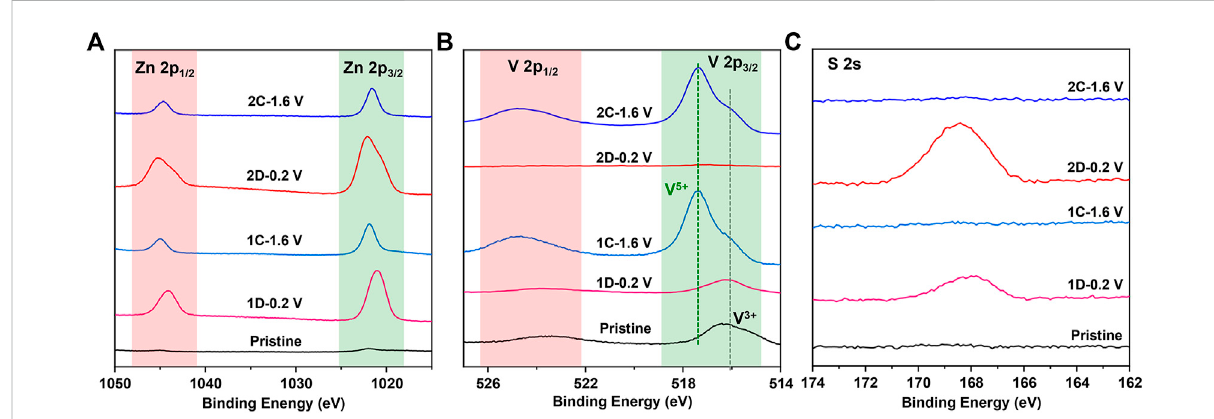
FIGURE 5 XPSspectraof (A) Zn2p, (B) V2p,and (C) S2sfortheV 2 O 3 @Ccathodeatpristinestate(Pristine),dischargedstateinthe fi rstorsecondcycle(1D- 0.2 V; 2D-0.2 V), and charged state in the fi rst cycle (1C-1.6V; 2C-1.6 V) in aqueous ZnSO 4 solution at 0.5 A g − 1 .